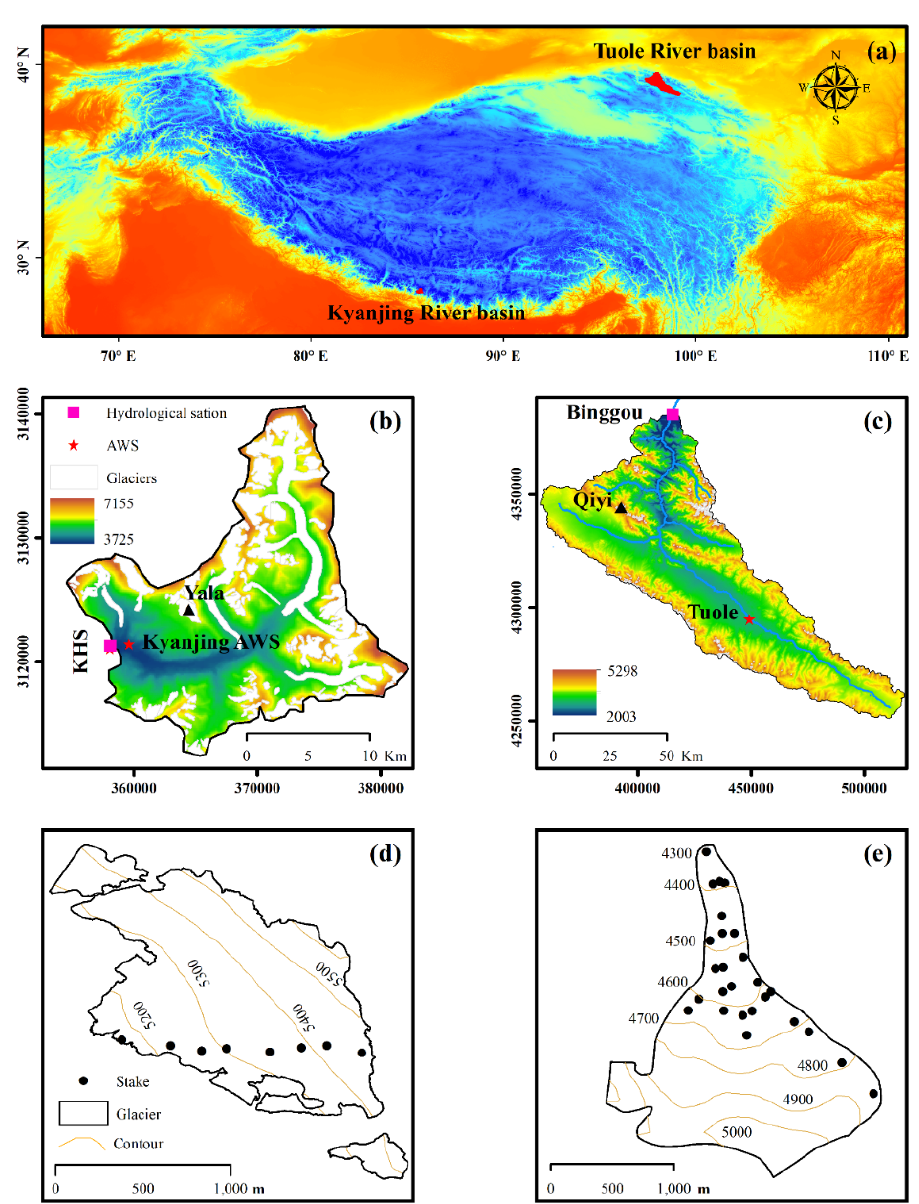
Figure 1. Locations of the Yala Glacier and Qiyi Glacier. In the figure, ( a ) is for the locations of the Yala Glacier and Qiyi Glacier, ( b , d ) are for the river basin where the Yalal Glacier is located and the contour map of the Yala Glacier, ( c , e ) for the river basin where the Qiyi Glacier is located and the contour map of the Qiyi Glacier.